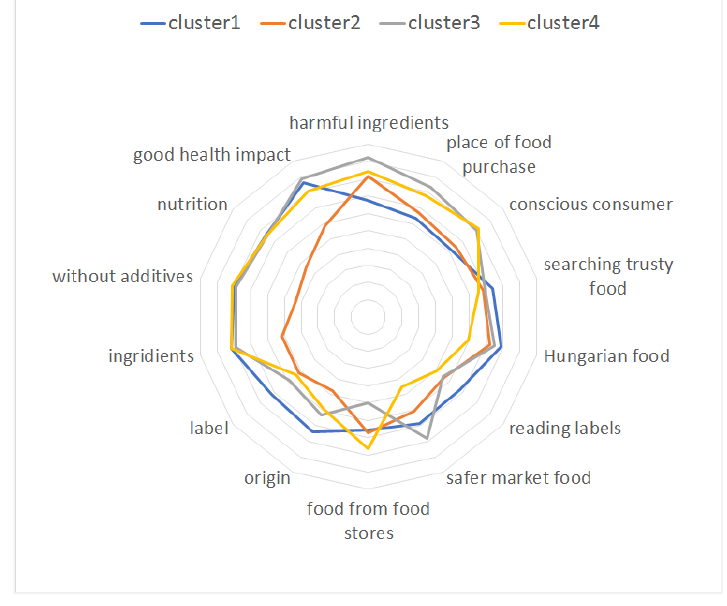
Figure 1. Images of each cluster (cluster 1, cluster 2, cluster 3, cluster 4). Table 1. Variables used for